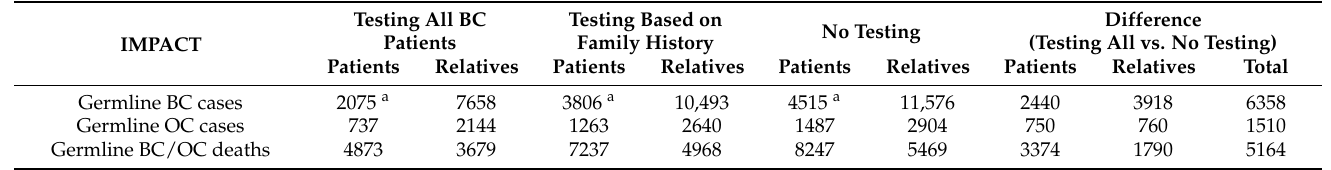
Table 3. Population effect of genetic testing for patients with